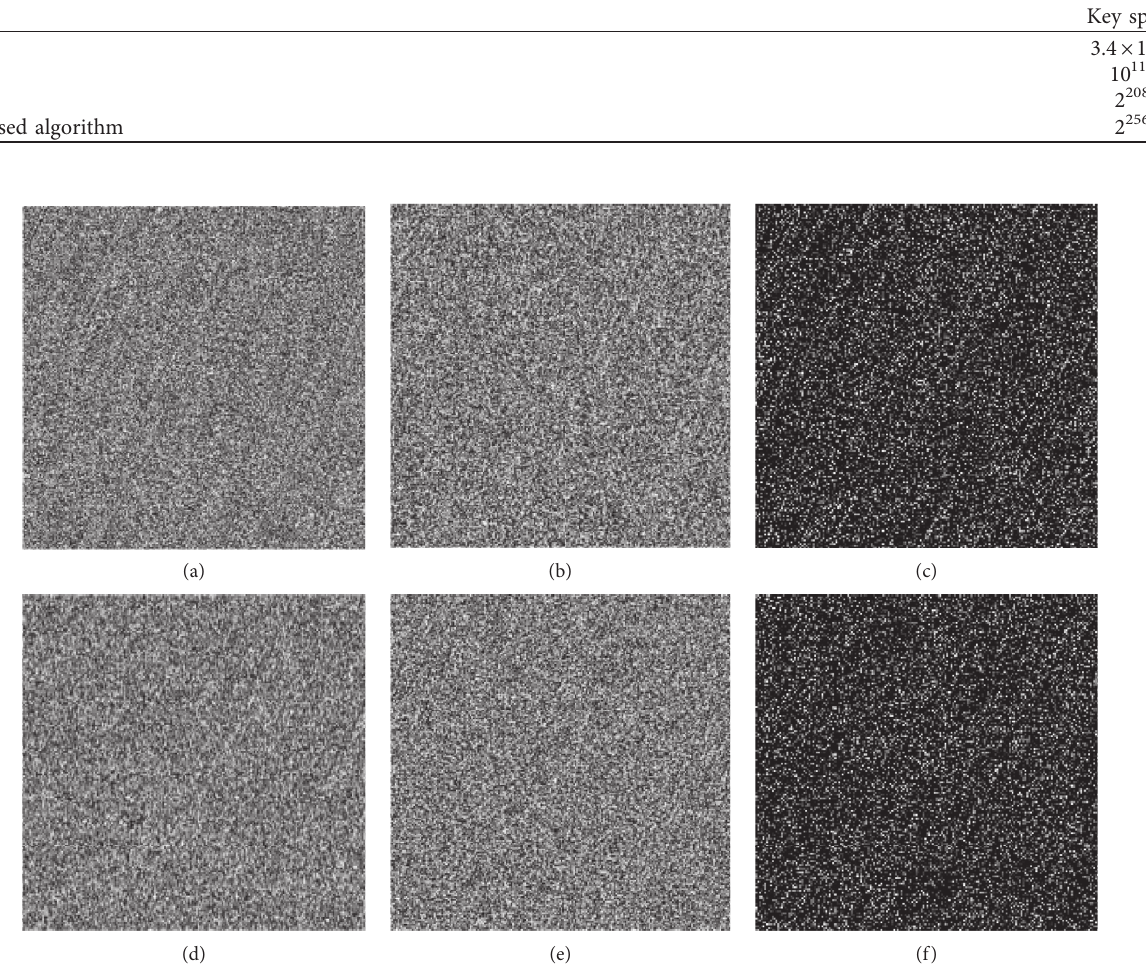
K i 1 , (b) encrypted Lena by key i 2 , (c) difference between , (e) decrypted (b) by key K i , and (f) difference between (d) and (e). 2 1